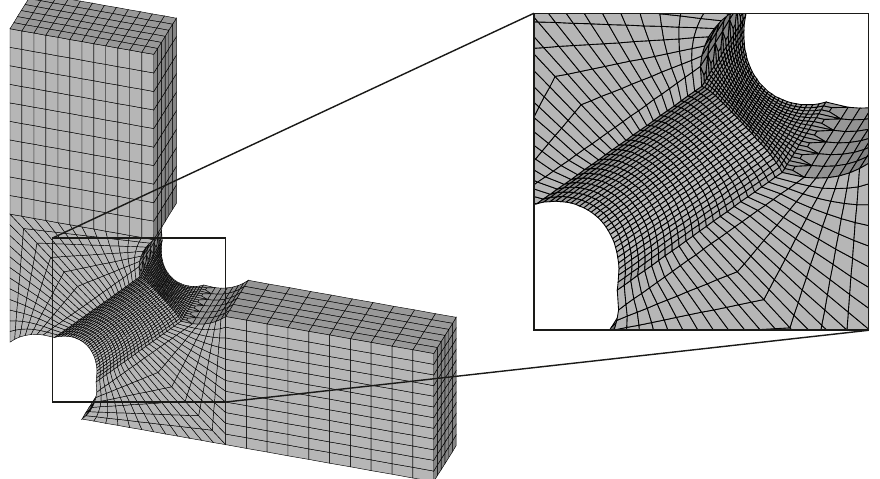
Figure 7. Finite element